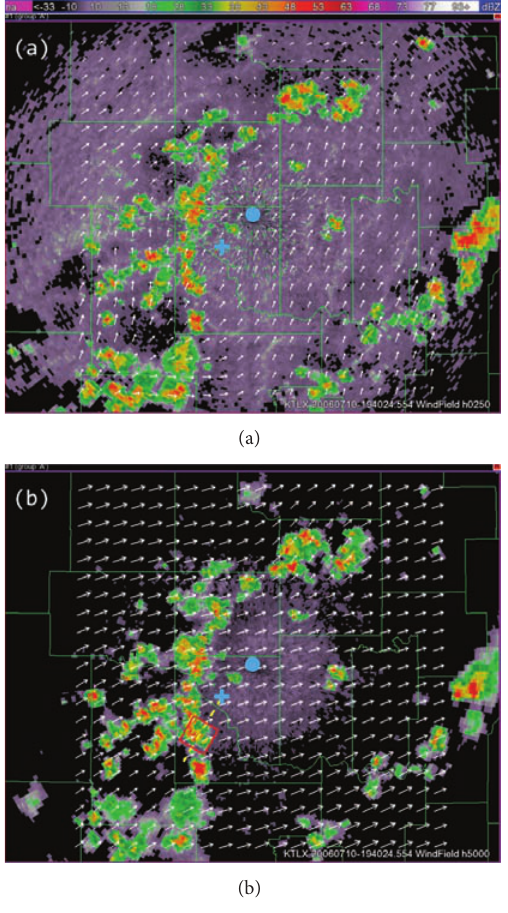
Figure 3: Background wind fields (shown by white arrows) pro- duced by the radar wind analysis system at 19 :40 :42 UTC at (a) 𝑧 = 0.25 km and (b) 𝑧 = 5 km superimposed on the KTLX reflectivity images at 0.5 ∘ and 3.3 ∘ tilts, respectively. The domain size is 160 × 160 × 8km 3 covered by an 81 × 81 × 32 grid centered at the KTLX radar site (marked by the blue dot). The blue + sign marks the PAR site. In panel (b), the red square box marks the nested domain used by the two-step SA method, and the yellow dashed line shows the radar beam direction from PAR along the 210.7 ∘